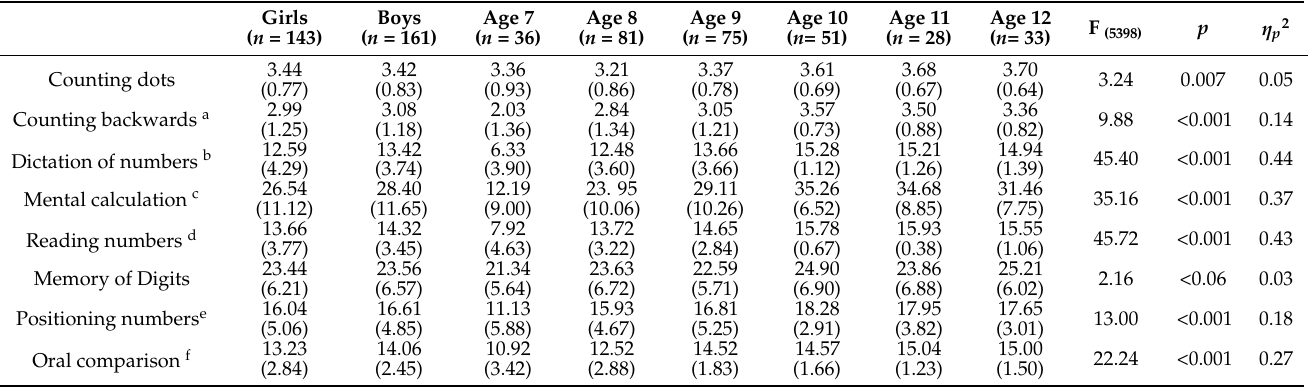
Table 3. Performance on Zareki-R subtests in Brazilian children per age and